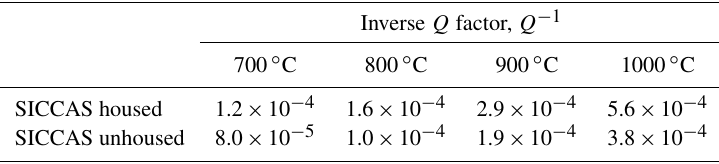
Table 7. Inverse Q factor of unhoused CTGS specimen and housed CTGS specimen (Schulz et al.,